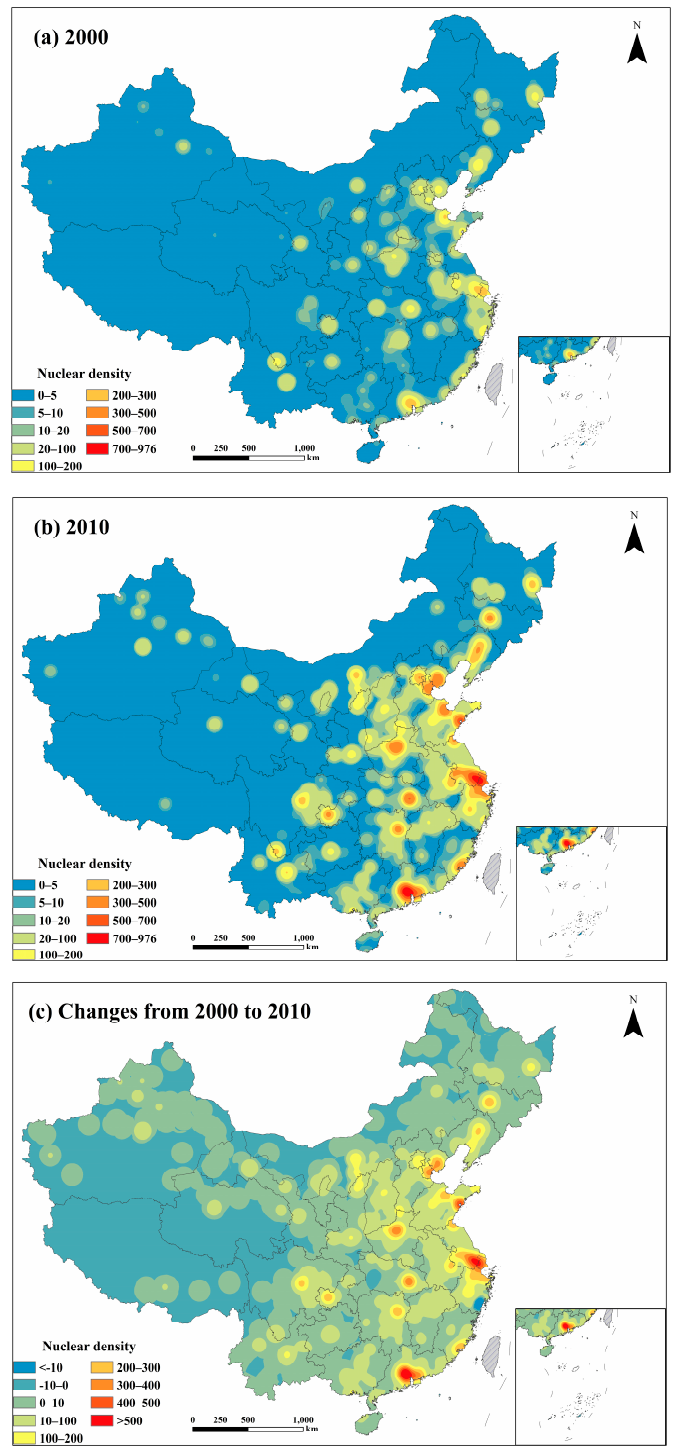
Figure 3. Kernel density estimation values of industrial output in 2000 ( a ) and 2010 ( b ); variation of kernel density estimation values of industrial output from 2000 to 2010 ( c